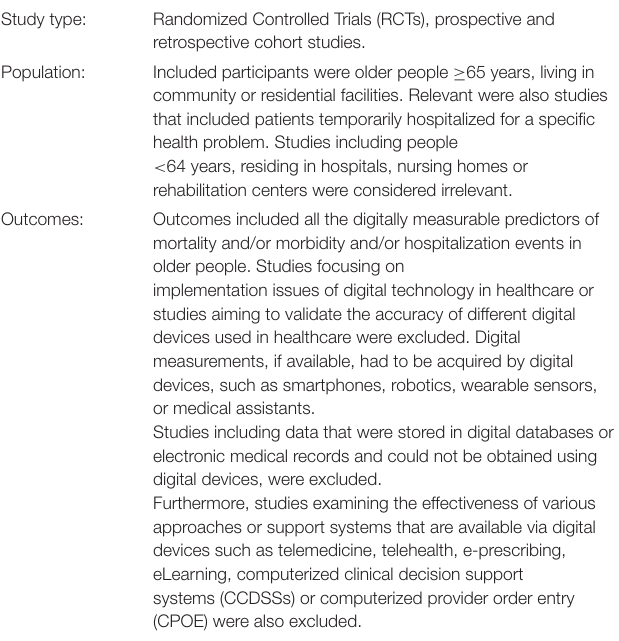
TABLE 1 | Characteristics of studies included in the final